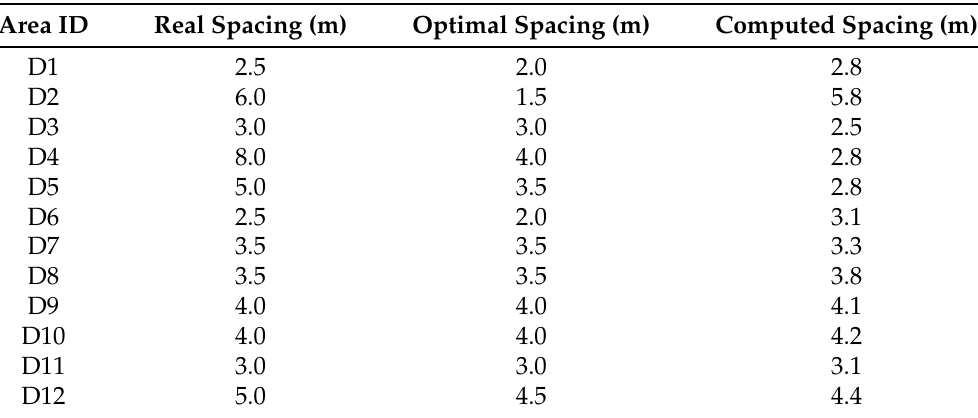
Table 4. Comparison between the measured, the optimal and the computed stem spacing.